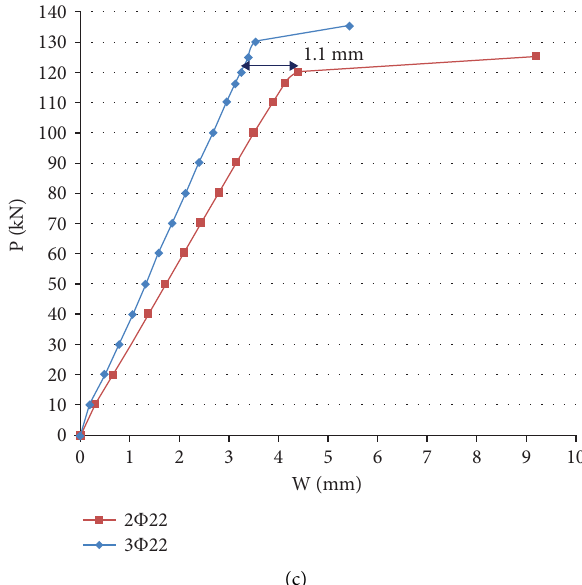
Figure 18: Relationship between load and stress, as well as between load and vertical displacement (efect of the number of tensile steel bars): (a) relationship between load and compressive stress, (b) relationship between load and tensile stress. (c) the relationship between load and VD.